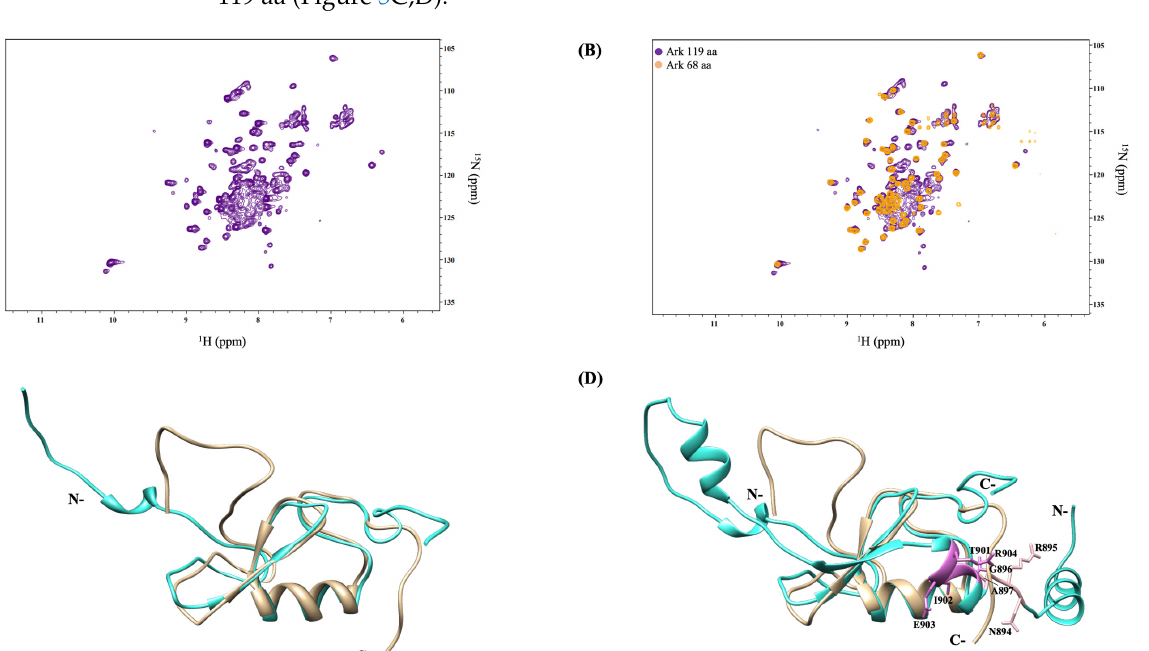
Figure 4. In vitro ubiquitination assays showing the formation of unanchored K63 ‐ linked chains after incubation of either Ark 68 aa or Ark 119 aa polypeptides using UBCH13/MMS2 E2 enzymes complex. All ubiquitination experiments were performed three times each.